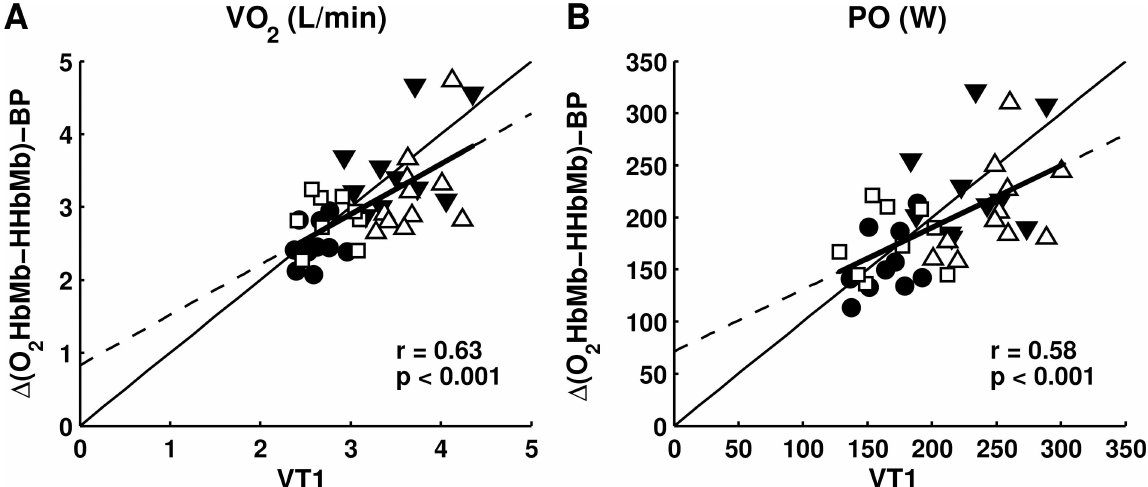
Fig 2. Relationship between Δ [O 2 HbMb-HHbMb]-BPand VT1. Δ [O 2 HbMb-HHbMb]-BPand VT1 are moderately relatedfor _ VO (a) en PO (b).Individual values are shown for male cyclists (closedtriangle),female cyclists (closedcircle),endurancetrainedmales (opensquare),recreationally trainedmales (opentriangle).The thick solid line representsthe best linearfit obtainedfromindividual data at Δ [O 2 HbMb-HHbMb]-BPand VT1 and the dottedline representsextrapolationof this best linearfit. The thin solid line is the line of